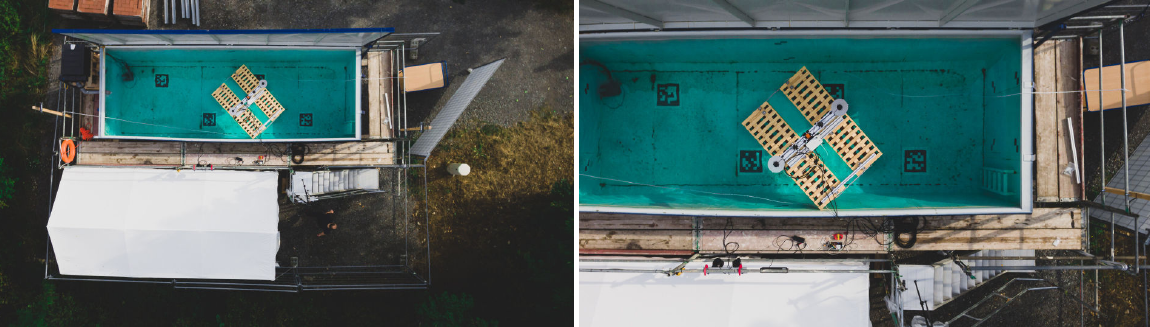
Figure 3. Top view of the water container. The placed AprilTags on the floor and an experimental setup with a raft can be seen. gear, which is driven by a stepper motor. This allows rotating the scanner to capture 360 deg scans. A magnetic encoder sealed in ner. All housings include embedded PCs with network